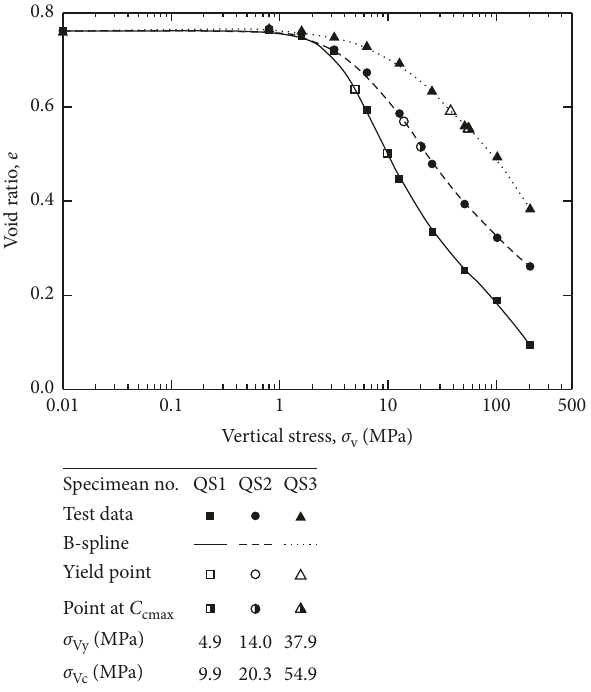
Figure 3: Relationship between e and σ